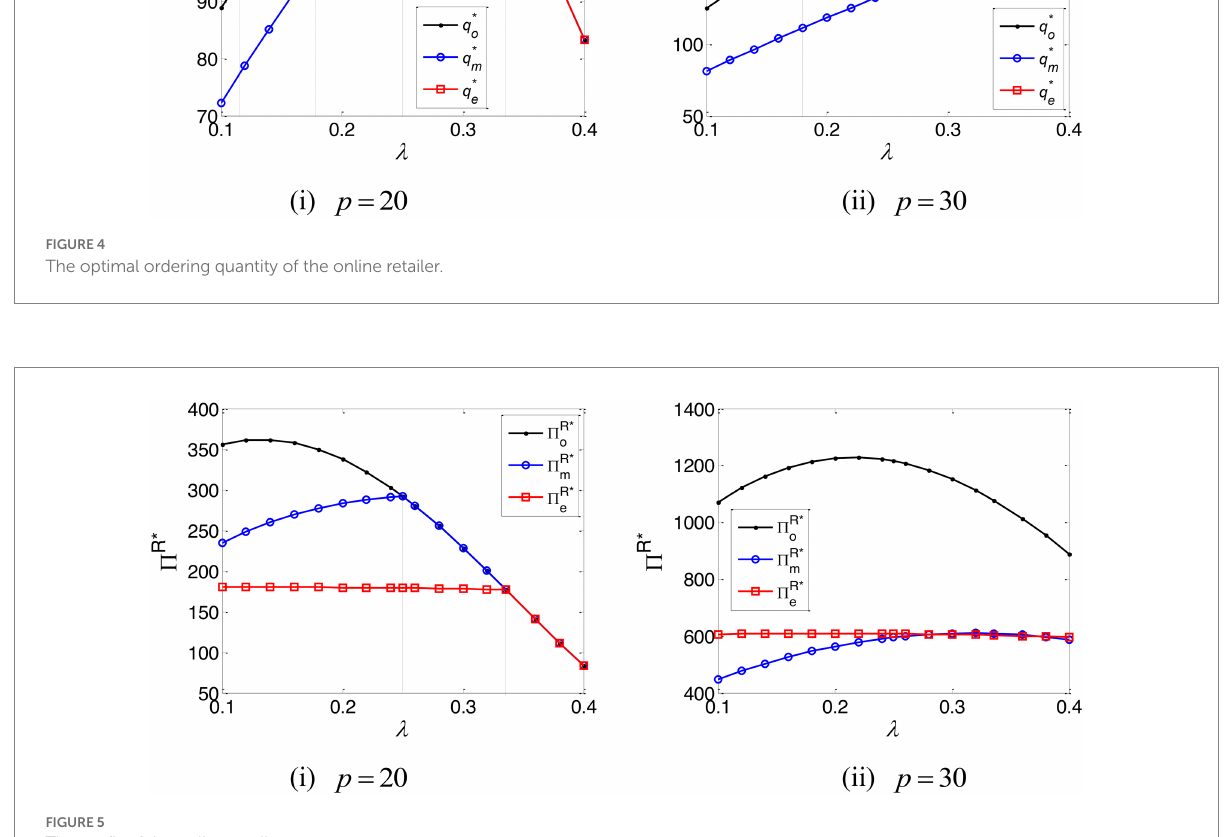
FIGURE 5 The profit of the online retailer.